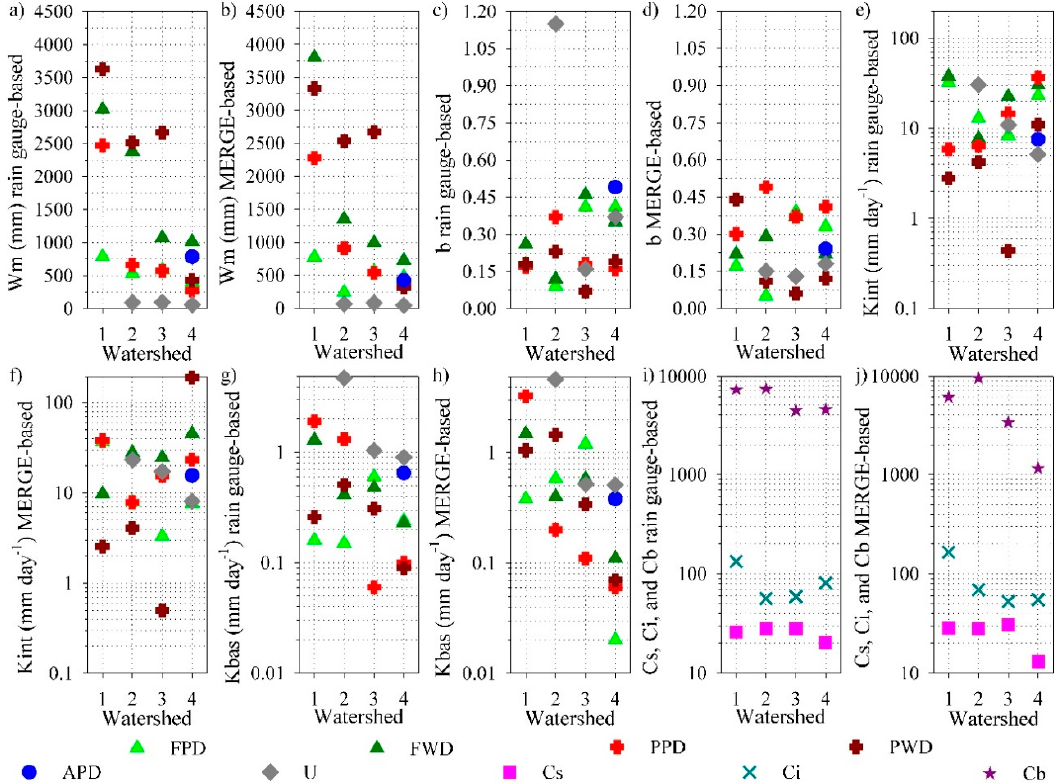
Figure 7. Calibrated parameters for the rain gauge and MERGE-based simulations. For parameters ( a,b ) Wm , ( c,d ) b , ( e,f ) Kint , ( g,h ) Kbas , and ( i,j ) Cs , Ci , Cb Table 2. Percentages of HRU in each watershed.